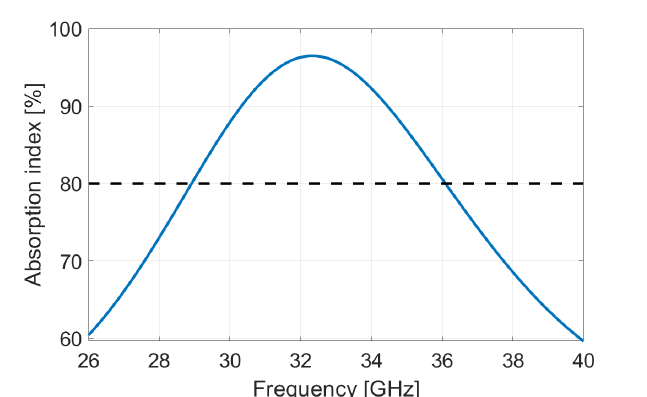
Figure 11. Simulation of absorption of rPLA–4%OMMT nanocomposite in Rozanov configuration, resulting in an optimization on the film thickness in order to reach the average absorption of 80%. The dotted line shows the target.